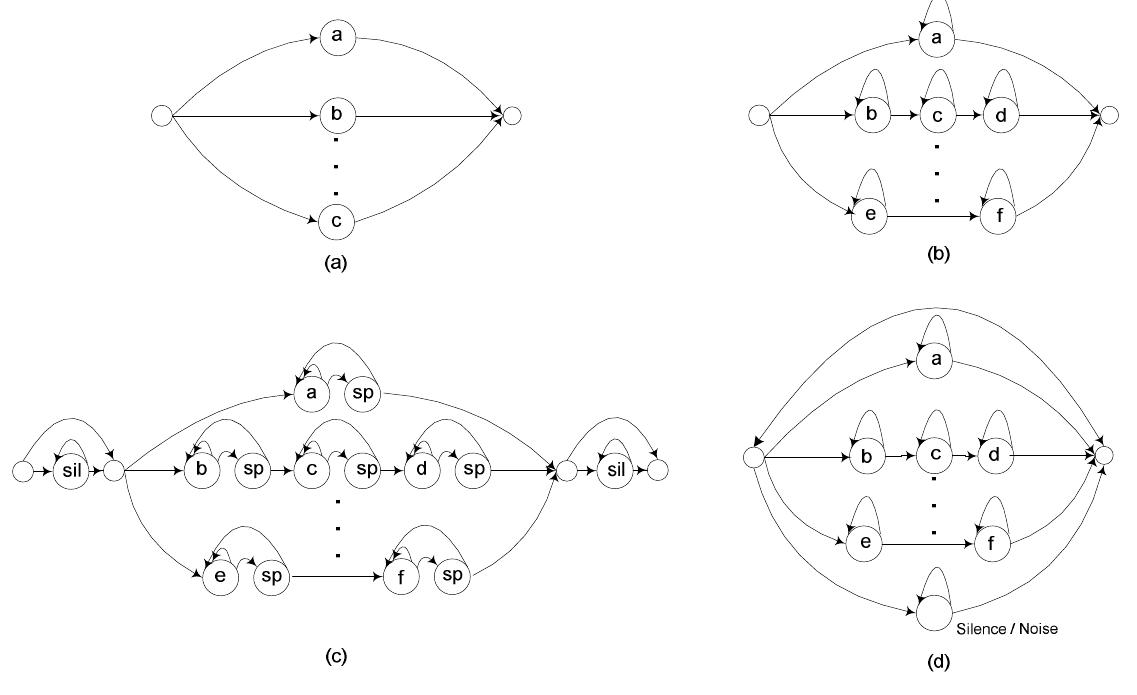
Figure 3. HMM recognition networks. Each unit represents an individual HMM, with the overall network representing allowable HMM sequences (a) Isolated vocalization network, exactly one HMM per vocalization and one vocalization per recording (b) Isolated vocalization network incorporating a constrained language model (c) Constrained model with optional inter-syllable short pauses and beginning/ending silence regions (d) Transformation into continuous detection